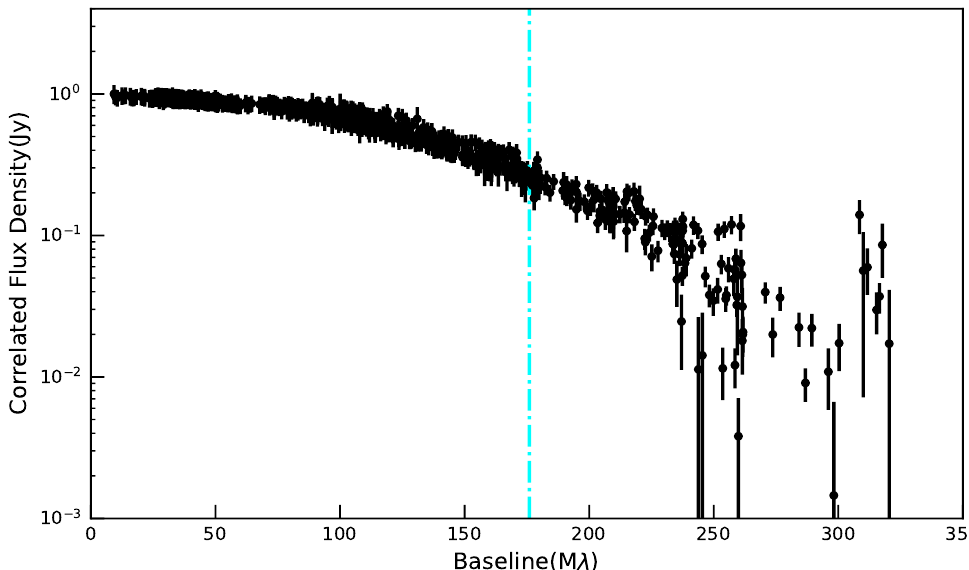
Figure 3. Normalized self-calibrated correlated flux density of SgrA ∗ at 43 GHz. The cyan-colored vertical line shows the “short” range. Each point has been 5 min averaged.